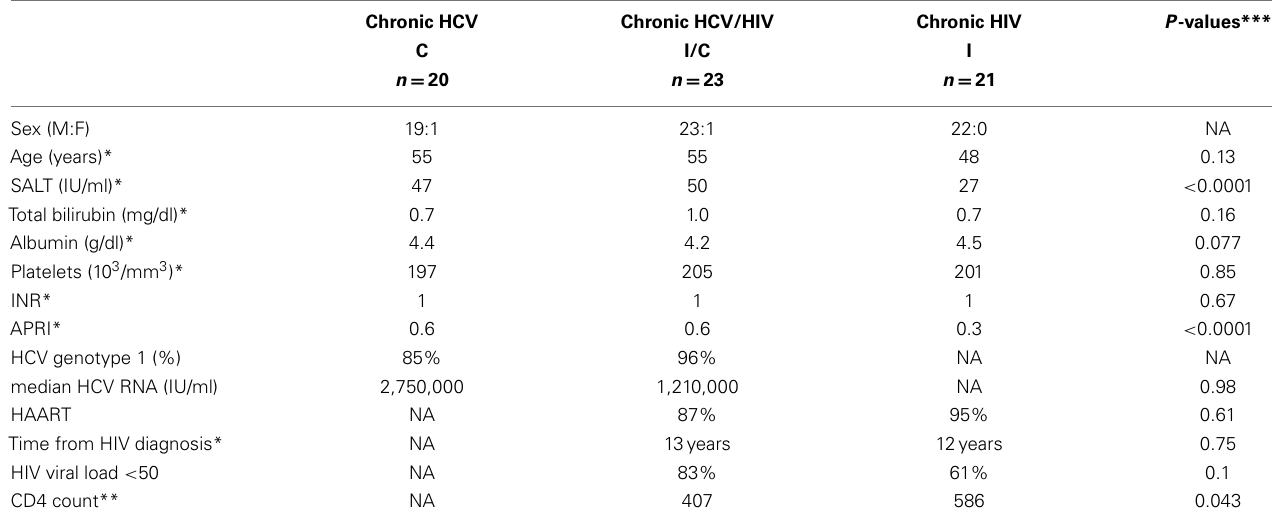
Table 1 | Patient groups . Chronic HCV Chronic HCV/HIV Chronic